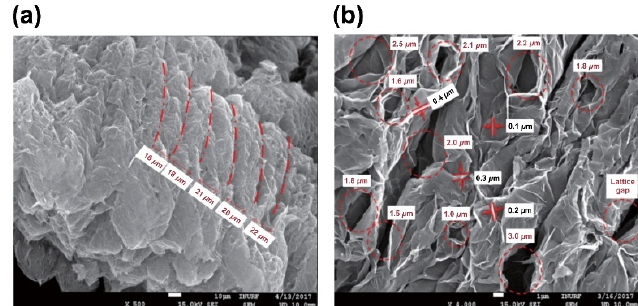
Figure 19. ( a ) Lattice layer gap in expanded graphite (500 × image) and ( b ) ultra-fine film structure of expanded graphite (4000× image).